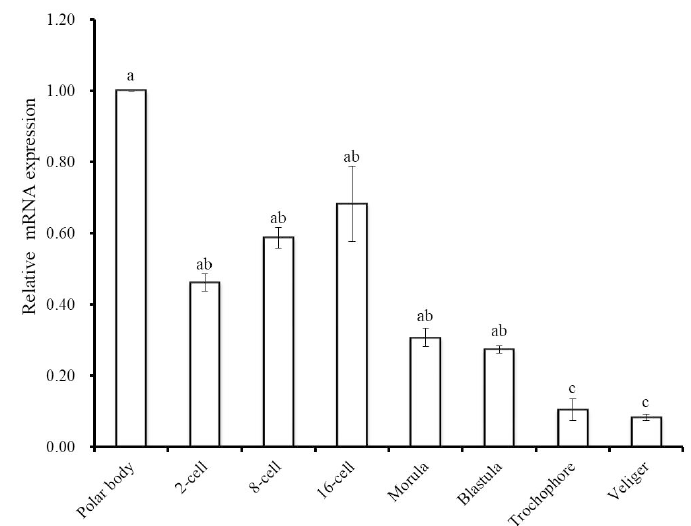
Figure 7. Expression levels of Hdh IGFBP-5 mRNA (means ± SD, N = 3) in different embryonic and larval stages of the H. discus hannai . Expression in all stages is normalized to expression in the polar body stage. Means not sharing the same letters are significantly different. Significantly higher expression was found in the polar body stage, which is indicated by a. No significant differences were observed in 2-cell, 8-cell, 16-cell, morula, and blastula stages, indicated by ab. c letter denote that there are no significant differences between trochophore and veliger larval stages.